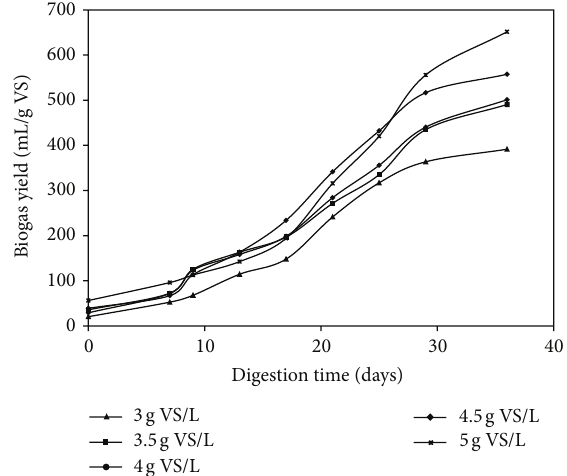
Figure 7: Biogas yield mL/gVS for grass waste.